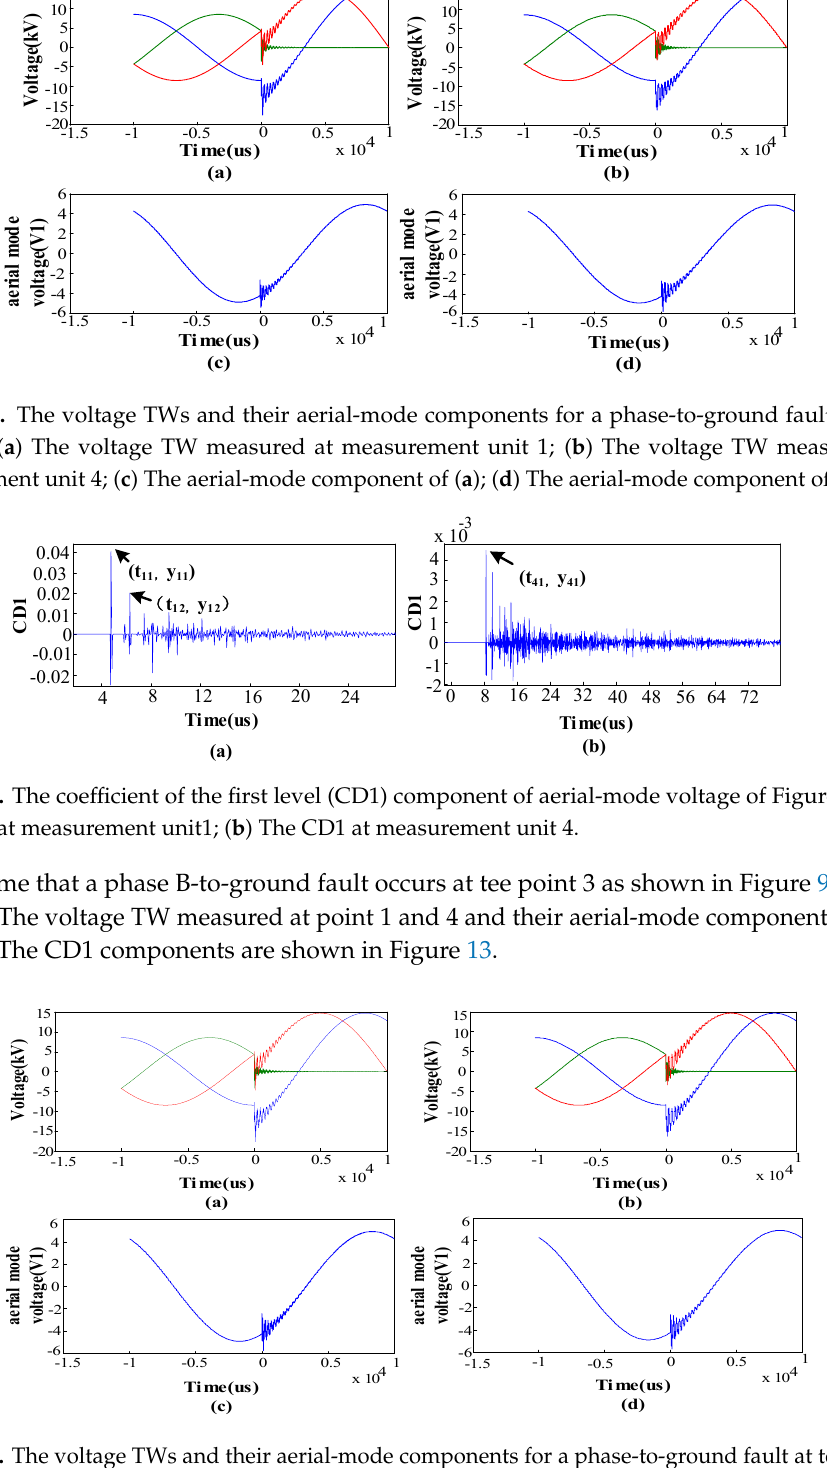
(b) Figure 13. The CD1 component of aerial-mode voltage of Figure 12. ( a ) The CD1 at measurement unit 1; ( b ) The CD1 at measurement unit 4. (3) Assume that a phase B-to-ground fault occurs at 4750 m to the terminal of branch 7–20 as shown in Figure 9b. The fault occurs at 0 s. This fault happens far away from the branch terminal, and the WTMM of the BTRW is much smaller than that of the IW. The voltage TW obtained at measurement unit 2 and 3 and their aerial-mode components are shown in Figure 14 and their CD1 components are shown in Figure 15. The distance from the fault point to measurement unit 2 is estimated as 2146.5 m by using the two IWs shown in Figure 15a,b. The difference between the calculated result and the exact length from tee point 7 to measurement 2 is less than 5 m. Considering an error tolerance, the fault is probably occurring on branch 7–20 or on the main line around tee point 7, as illustrated in Figure 9b. To distinguish the false position, several reflected TWs are taken into account. Regarding a single measurement unit (unit 2), as shown in Figure 15a, the time difference between IW and WTMM2 results in a distance difference of 294 m, which corresponds to the length of branch 5–16 in Figure 9b. Similarly, the reflection distance related to WTMM3 is 498 m which